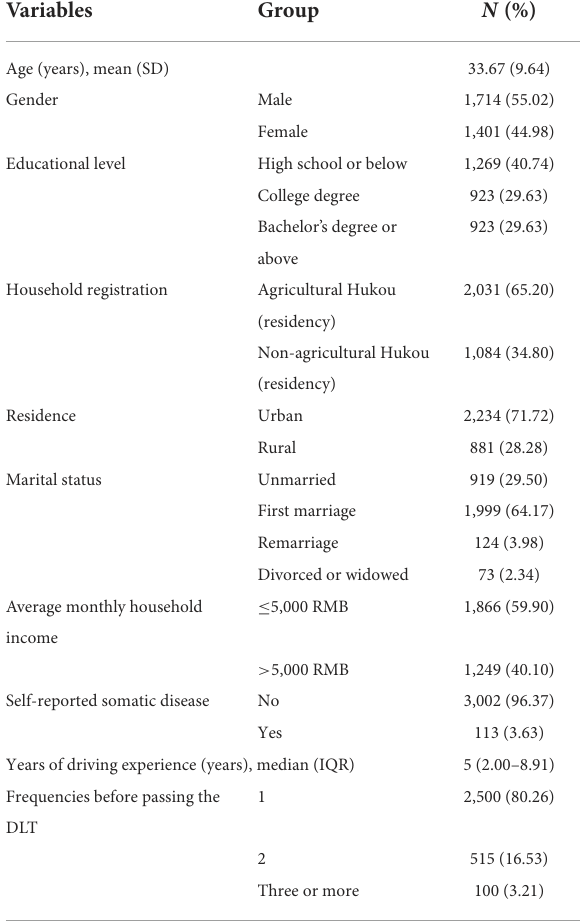
TABLE 2 Demographic characteristics of all 3,115 investigated private car